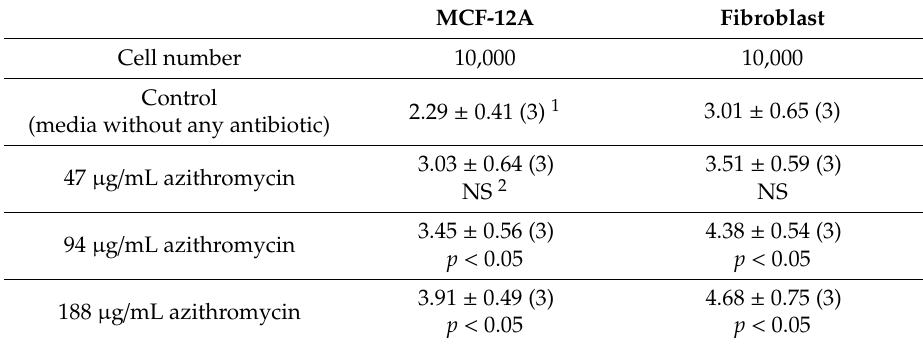
Table 1. Lactate production of cell lines cultured in the media without or with azithromycin addition. L-lactate concentration ( µ M) was measured by the Cayman glycolysis cell-based assay kit.